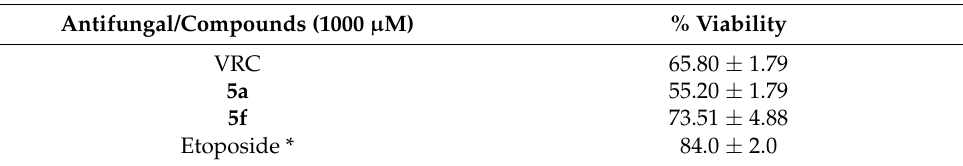
Table 5. Cytotoxicity in a healthy COS-7 cell against voriconazole antifungal and compounds 5a and 5f explored by MTT